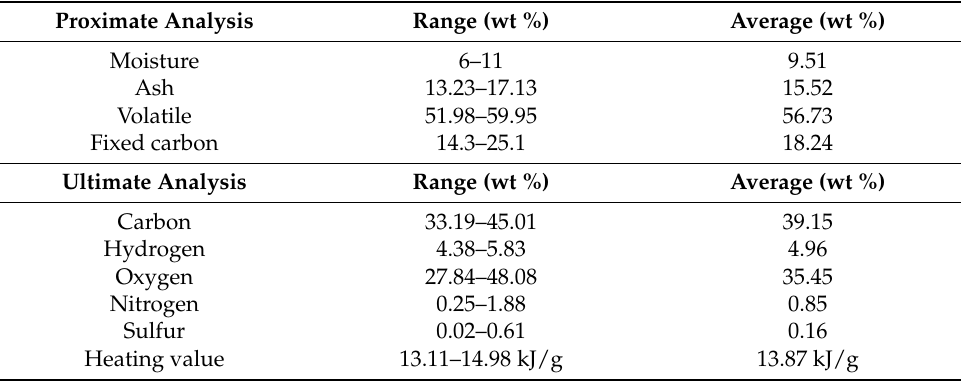
Figure 4. Iteration procedure of the GBR model.